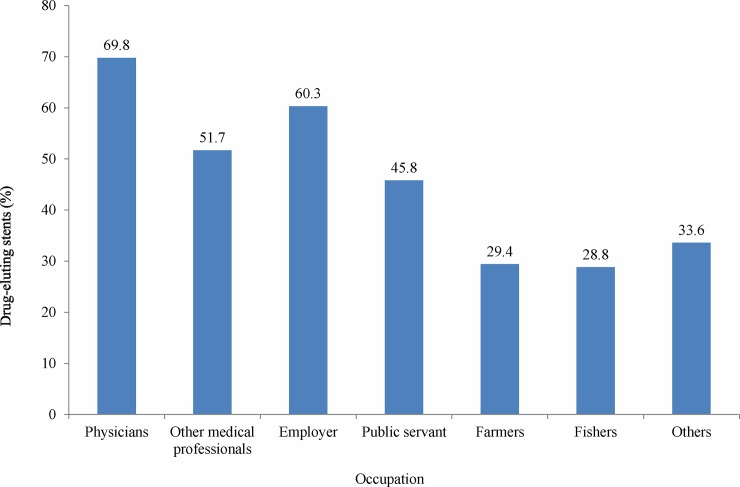
Proportion of patients received DES, by occupation.